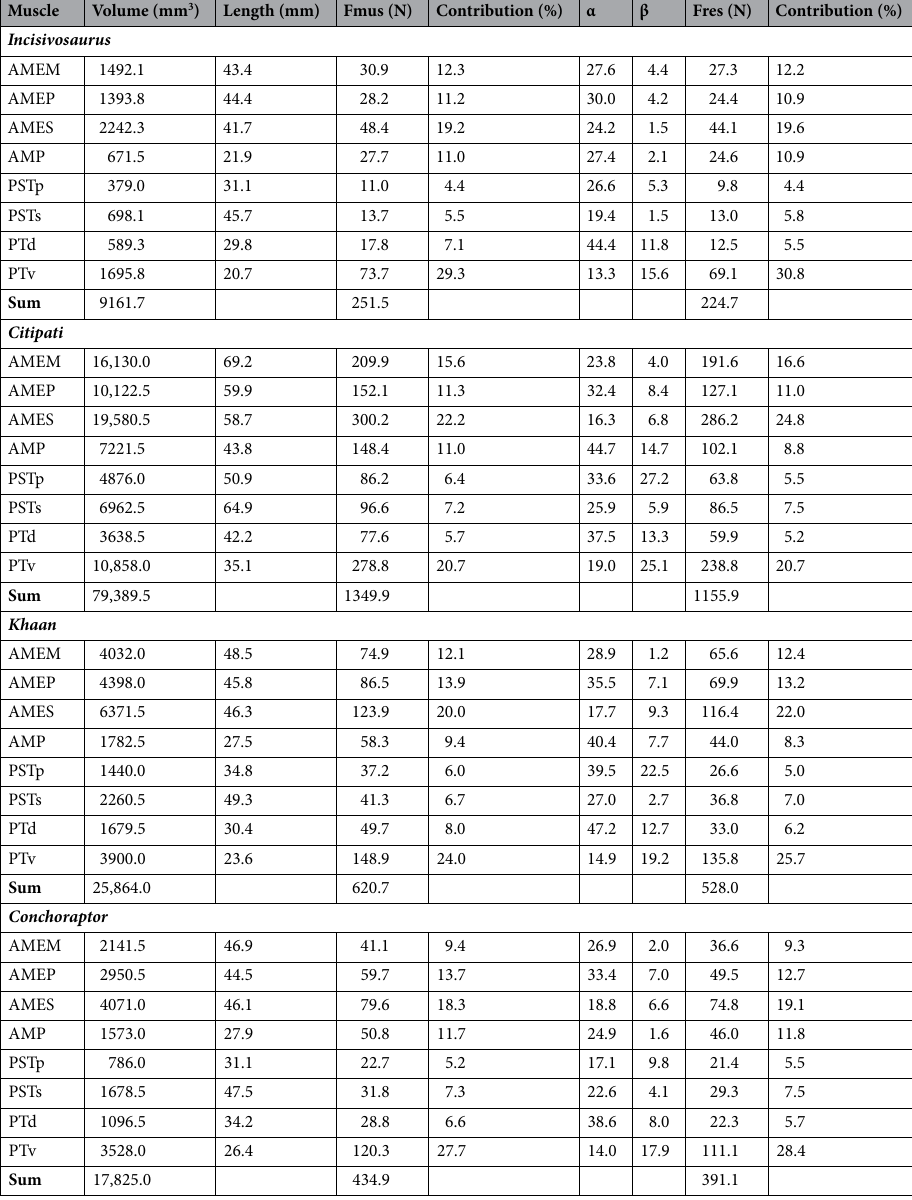
Table 1. Geometric measurements of reconstructed muscles and estimated contraction force (Fmus = (volume / length) × 0.3 N/mm 2 × 1.5 32,34 ). Insertion angles of muscles measured in the sagittal ( α ) and coronal ( β ) planes used to calculate resultant vertical force acting on mandible ( Fres = Fmus × cos α × cos β